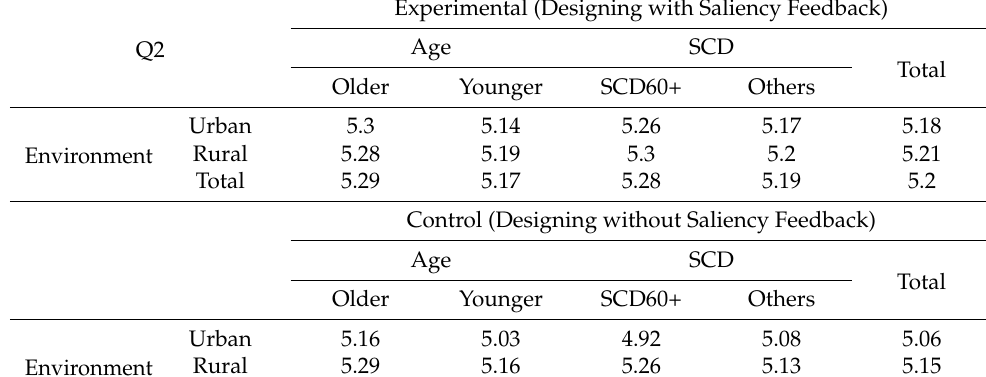
Table A2. Descriptive statistics of the crowd ratings for design quality assessment item Q2 (“aesthetic value”).